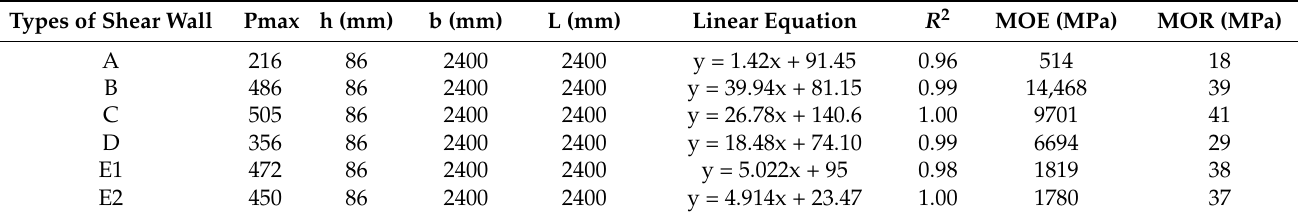
Table 2. Stiffness (MOE) and strength (MOR) of some shear wall panel components.